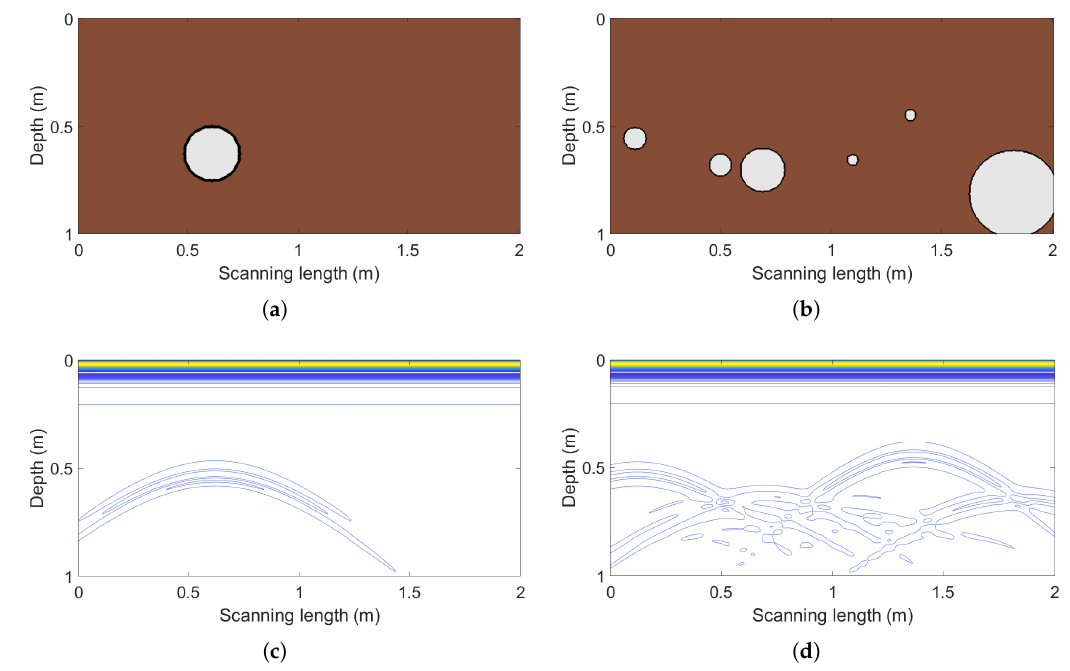
Figure 1. ( a ) Example subsurface section with only one pre-buried pipeline, where the brown color represents the soil and the white color represents the pipeline. ( b ) Example subsurface section with multiple pre-buried pipelines. ( c ) GPR signal profile corresponding to the subsurface section in panel (a). ( d ) GPR signal profile corresponding to the subsurface section in panel